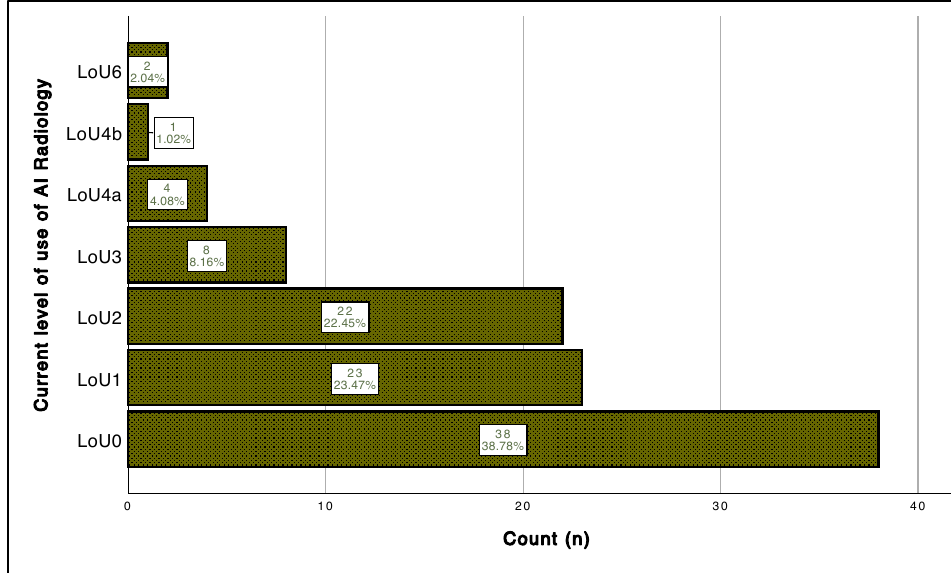
Figure 1. The current levels of use of AI radiology. The vertical axis represents the current level of use of AI. The horizontal axis represents the number of participants. LoU: level of use; AI: artificial